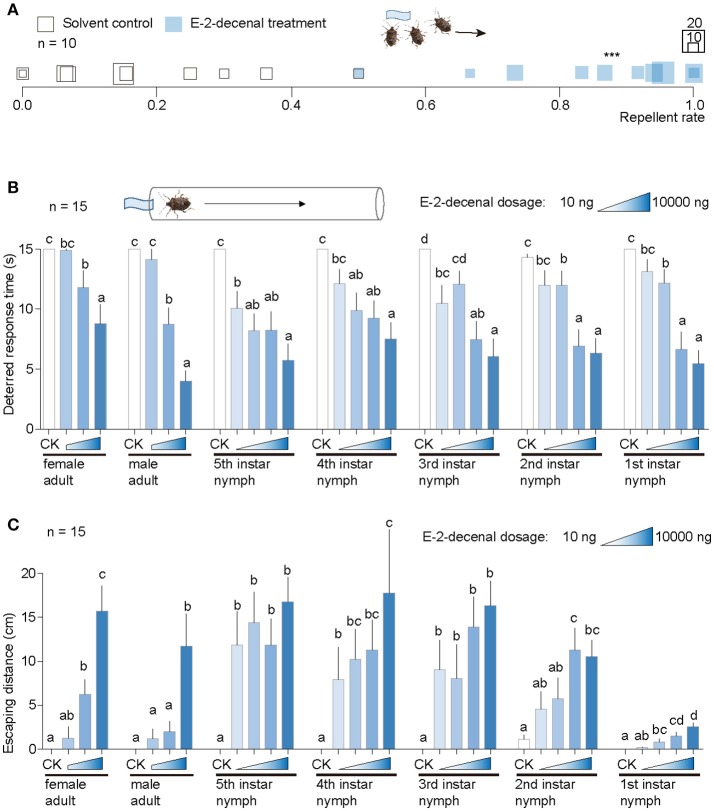
Behavioral responses of H. halys to (E)-2-decenal. (A) Results from a grouped test with 30 H. halys for each replicate. (E)-2-decenal was used at a dosage of 10 μg and solvent n-hexane was used as control. Square sizes indicate aggregated numbers of H. halys adults. Repellent rates for (E)-2-decenal and control were 84.1 ± 5.14% and 18.47 ± 5.25%, respectively. ***Indicates significant difference was observed between (E)-2-decenal and control [student's t-test, t(18) = 2.1, P < 0.001]. (B) Comparison of deterred response times of single H. halys in each developmental stage among (E)-2-decenal dosages. Solvent was used as control (CK). Different lower case letters indicate significant differences were observed among dosages in each developmental stage of H. halys [GLM and Tukey HSD, female adults: F(3, 86) = 15.0, P < 0.0001; male adults: F(3, 86) = 63.03, P < 0.0001; fifth instar nymphs: F(4, 115) = 26.2, P < 0.0001; fourth instar nymphs: F(4, 115) = 18.17, P < 0.0001; third instar nymphs: F(4, 115) = 24.88, P < 0.0001; second instar nymphs: F(4, 115) = 20.98, P < 0.0001; first instar nymphs: F(4, 115) = 40.11, P < 0.0001]. Error bars indicate + s.e.m. (C) Comparison of escaping distances of single H. halys in each developmental stage among (E)-2-decenal dosages. Solvent was used as control (CK). Different lower case letters indicate significant differences were observed among dosages in each developmental stage of H. halys [GLM and Tukey HSD, female adults: F(3, 86) = 32.15, P < 0.0001; male adults: F(3, 86) = 13.36, P < 0.0001; fifth instar nymphs: F(4, 115) = 18.5, P < 0.0001; fourth instar nymphs: F(4, 115) = 13.62, P < 0.0001; third instar nymphs: F(4, 115) = 14.55, P < 0.0001; second instar nymphs: F(4, 112) = 11.05, P < 0.0001; first instar nymphs: F(4, 115) = 22.78, P < 0.0001]. Error bars indicate + s.e.m.